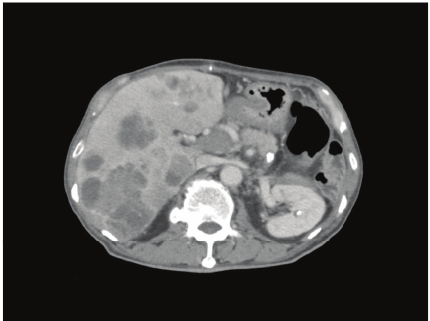
Figure 5: Abdominal computed tomography at the time of recur- rence. Multiple liver metastases with portal thrombosis were found 8 weeks after